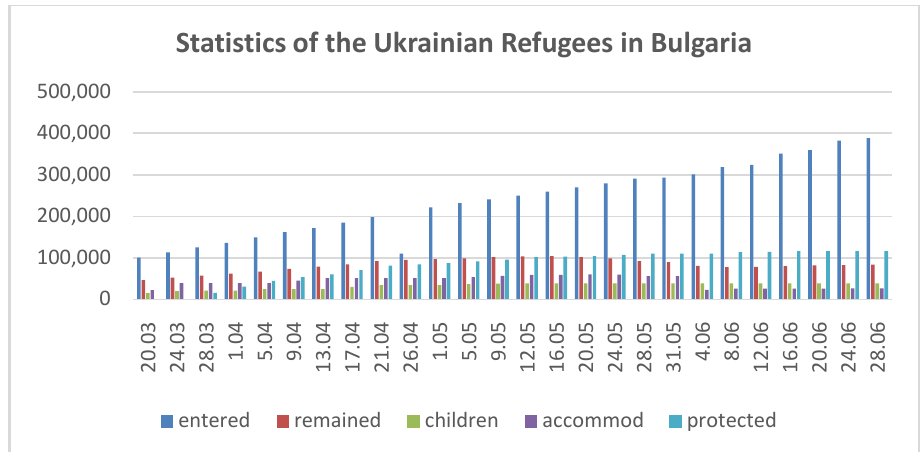
Figure 1: Distribution of the Ukrainian Refugees in Bulgaria March-June 2022: Entered, Remained, Children, Accommodated and Protected (Source: BfU